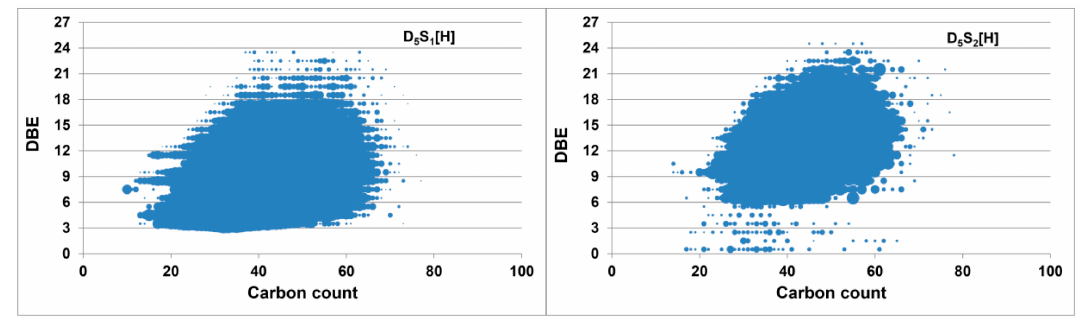
Figure 7. DBE versus carbon number plots for the D 5 S 1 and D 5 S 2 classes from the deuterated ethylated heavy crude oil.